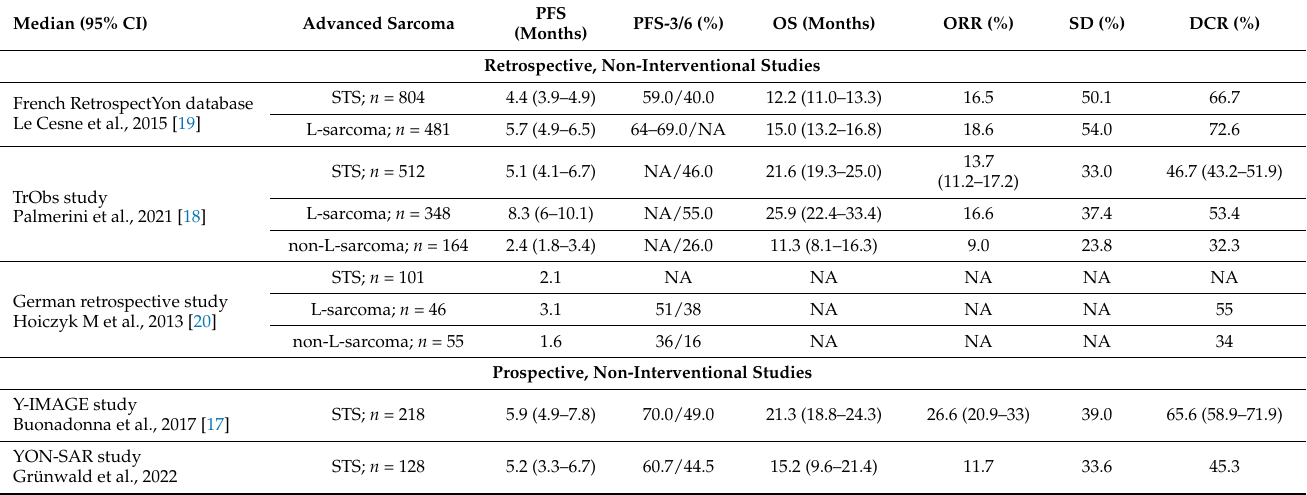
Table 6. Relevance of the YON-SAR results within the context of trabectedin treatment for recurrent advanced